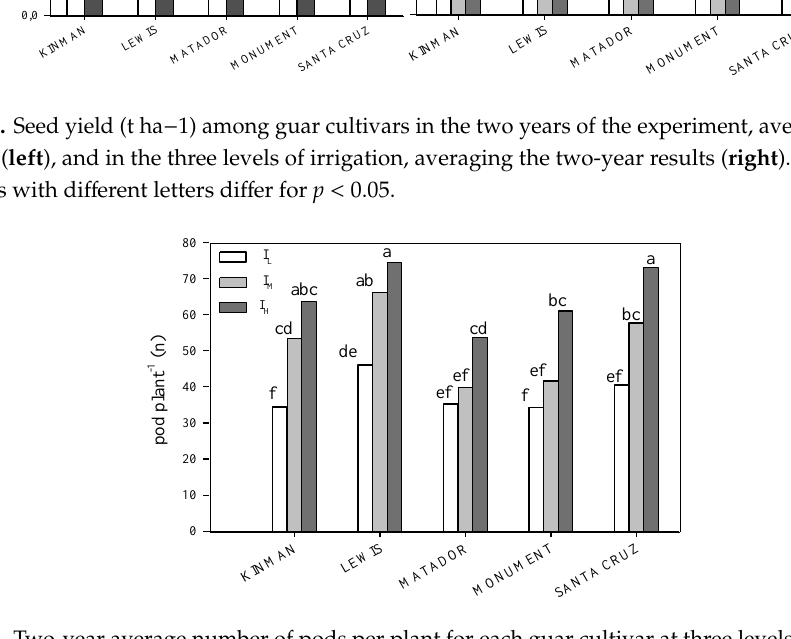
irrigation. Bars with different letters differ for p < 0.05. Bars with di ff erent letters di ff er for p < 0.05.